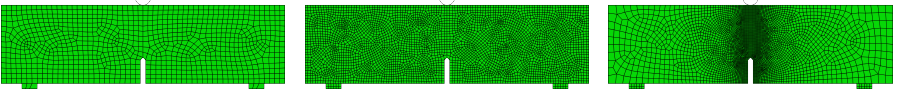
Figure 10. Meshes adopted in the analyses. Mean mesh size in the vicinity of the notch ( left to right ): 10 mm, 5 mm, and 2 mm.